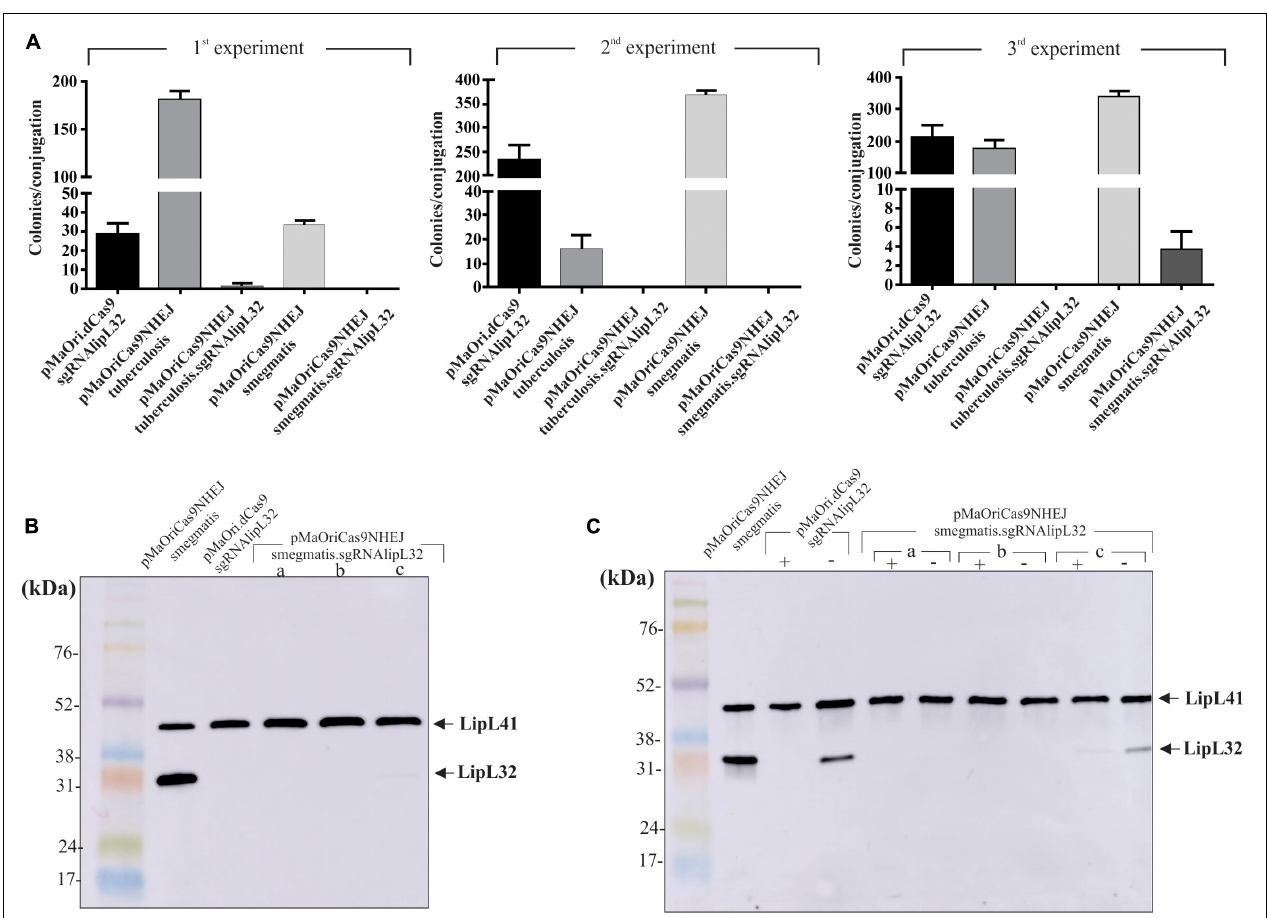
FIGURE 5 | LipL32 knockout in L. interrogans by CRISPR/Cas9 and NHEJ from M. smegmatis. (A) Distinct plasmids were transferred to L. interrogans cells by conjugation with E. coli β 2163 and then plated onto EMJH plus spectinomycin plates for cell enumeration (colonies per conjugation) in three independent experiments. Clones were recovered from plates and then evaluated by immunoblotting with anti-LipL32 (1:8,000) and anti-LipL41 (1:4,000) polyclonal antibodies for confirming LipL32 knockout. Protein profiles of clones grown in the presence of spectinomycin (B) or presence (+) and absence (–) of the antibiotic after five in vitro passages (C) are shown. L. interrogans cultures harboring pMaOriCas9NHEJsmegmatis and pMaOri.dCas9sglipL32 were included as positive and negative controls for LipL32